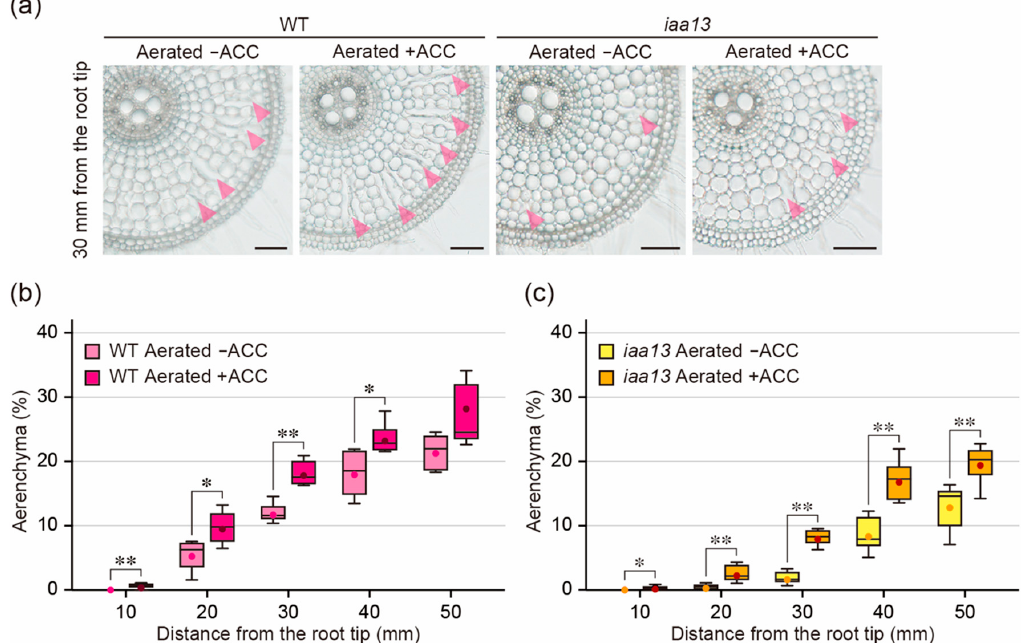
Figure 2. Aerenchyma formation under aerated conditions with or without 1-aminocyclopropane-1-carboxylic acid (ACC) treatment. ( a ) Cross-sections at 30 mm from the tips of adventitious roots of the wild type (WT) and iaa13 mutant. Aerenchyma is indicated by magenta arrowheads. Bars = 100 µ m. ( b , c ) Percentages of aerenchyma in root cross-sectional area at 10, 20, 30, 40, and 50 mm. Twenty-day-old aerobically grown WT ( b ) and iaa13 ( c ) seedlings were further grown under aerated conditions with or without 10 µ M ACC for 48 h. ( b , c ) Significant di ff erences between the conditions at p < 0.05 and p < 0.01 are denoted by * and **, respectively (two-sample t -test). Boxplots show the median (horizontal lines), 25th to 75th percentiles (edges of the boxes), minimum to maximum (edges of the whiskers) and mean values (dots in the boxes) ( n = 6).